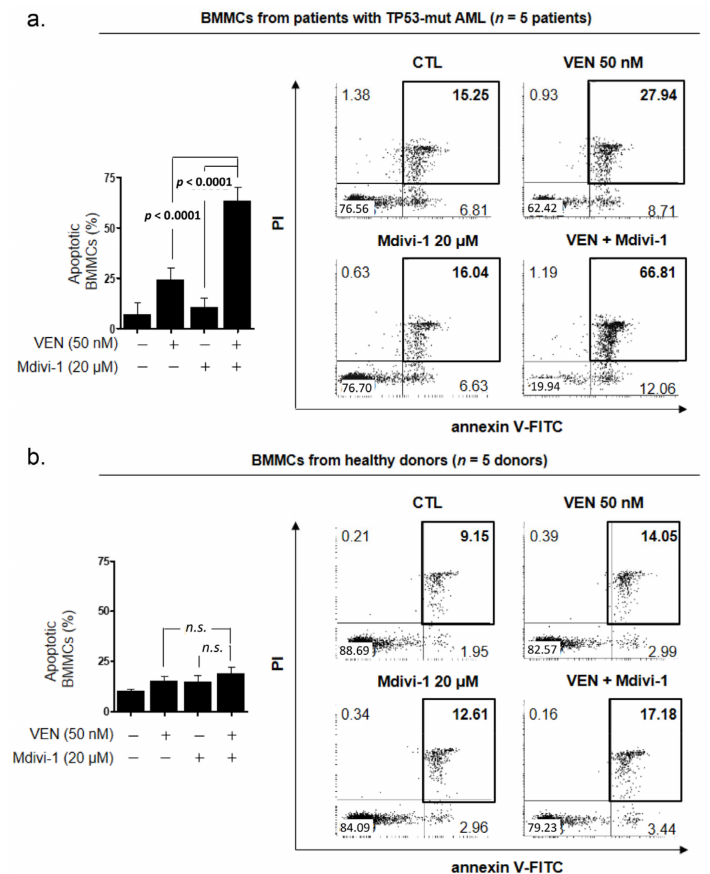
Figure 3. Sensitization of TP53mut AML cells, but not normal bone marrow mononuclear cells (BMMCs), to venetoclax-induced apoptosis via DRP1 inhibition. ( a , b ) BMMCs from patients